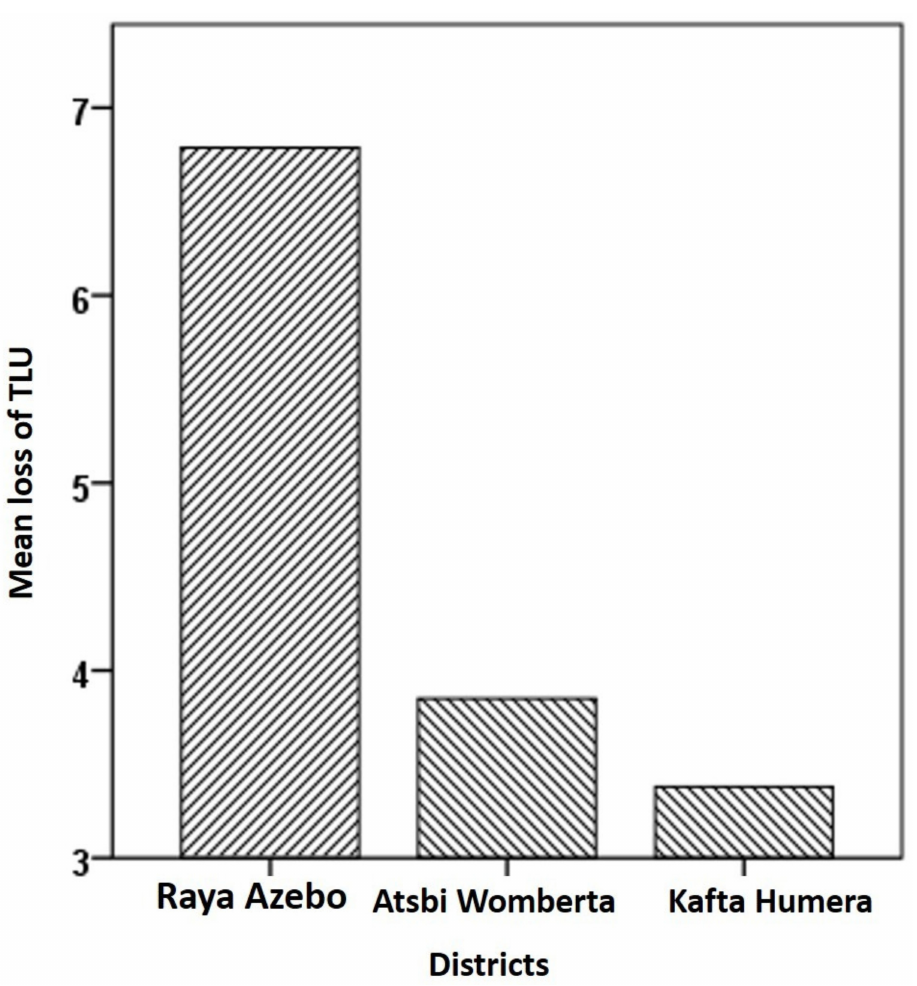
Figure 3. Livestock loss due to drought-related risks in the 2010s. (The tropical livestock unit (TLU) is commonly taken to be an animal of 250 kg live